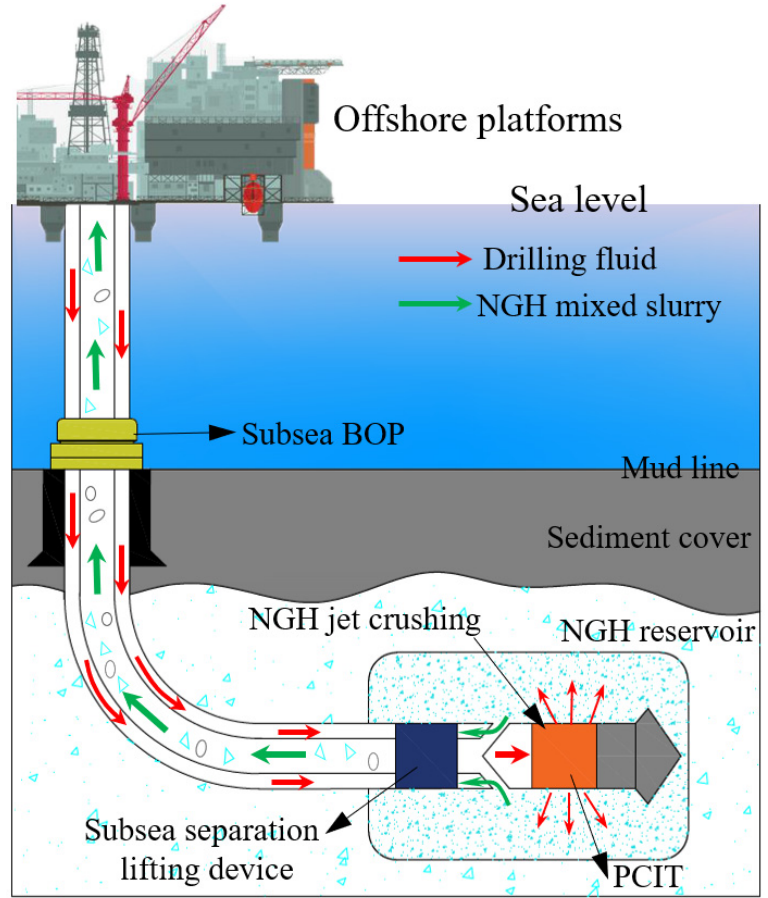
Figure 1. Solid fluidization exploitation method.